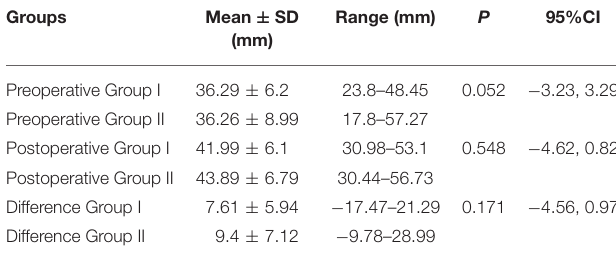
TABLE 3 | Comparison of radiographic